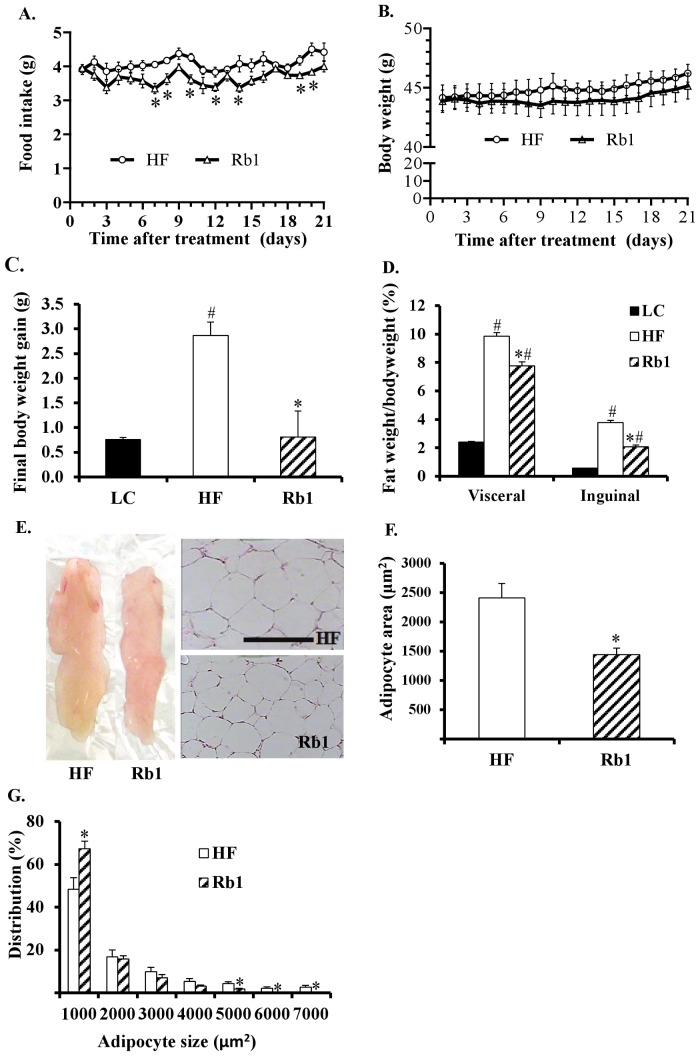
Effect of chronic administration of Rb1 on food intake, body weight and fat in obese mice fed a HF diet for 16 weeks.Rb1 treatment reduced food intake (A), final body weight gain (C), and visceral and inguinal fat mass (D) (n = 8). Panel B: Body weight of obese mice with or without Rb1 chronic treatment for 21 days. Panel E: Photographs of epididymal fat tissue, and hematoxylin and eosin staining of epididymal fat tissue, scale bar: 100 μm. Panel F: Adipocyte area in epididymal fat. Panel G: Frequency distribution of adipocyte surface area in epididymal fat. *p<0.05 vs. HF control group, #p<0.05 vs. LC lean control.